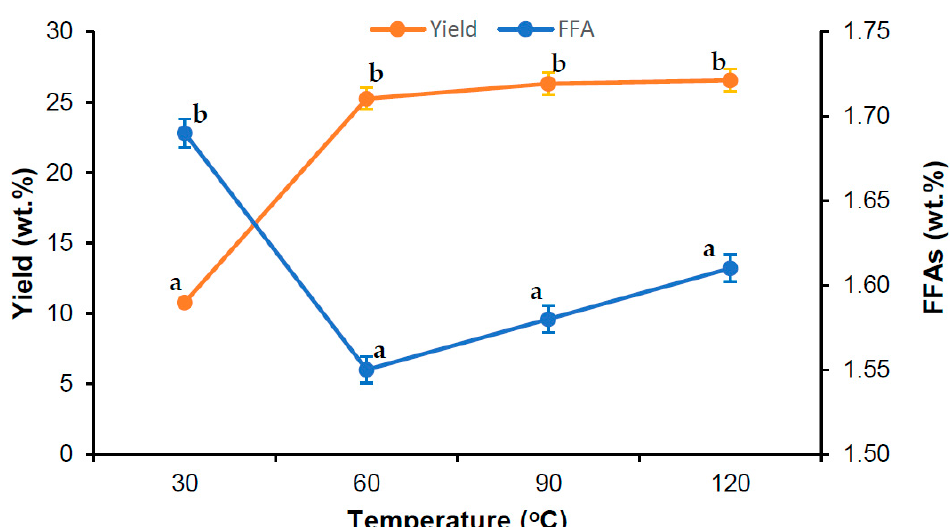
Figure 2. Effect of sterilization temperature in VPO extraction using cold press technology. Experimental conditions: time 60 min; amount of fresh palm fruits: 5 kg. Means of triplicates ± standard deviation. Means followed by different letters in the same line demonstrated significant difference by Tukey test ( p < 0.05).